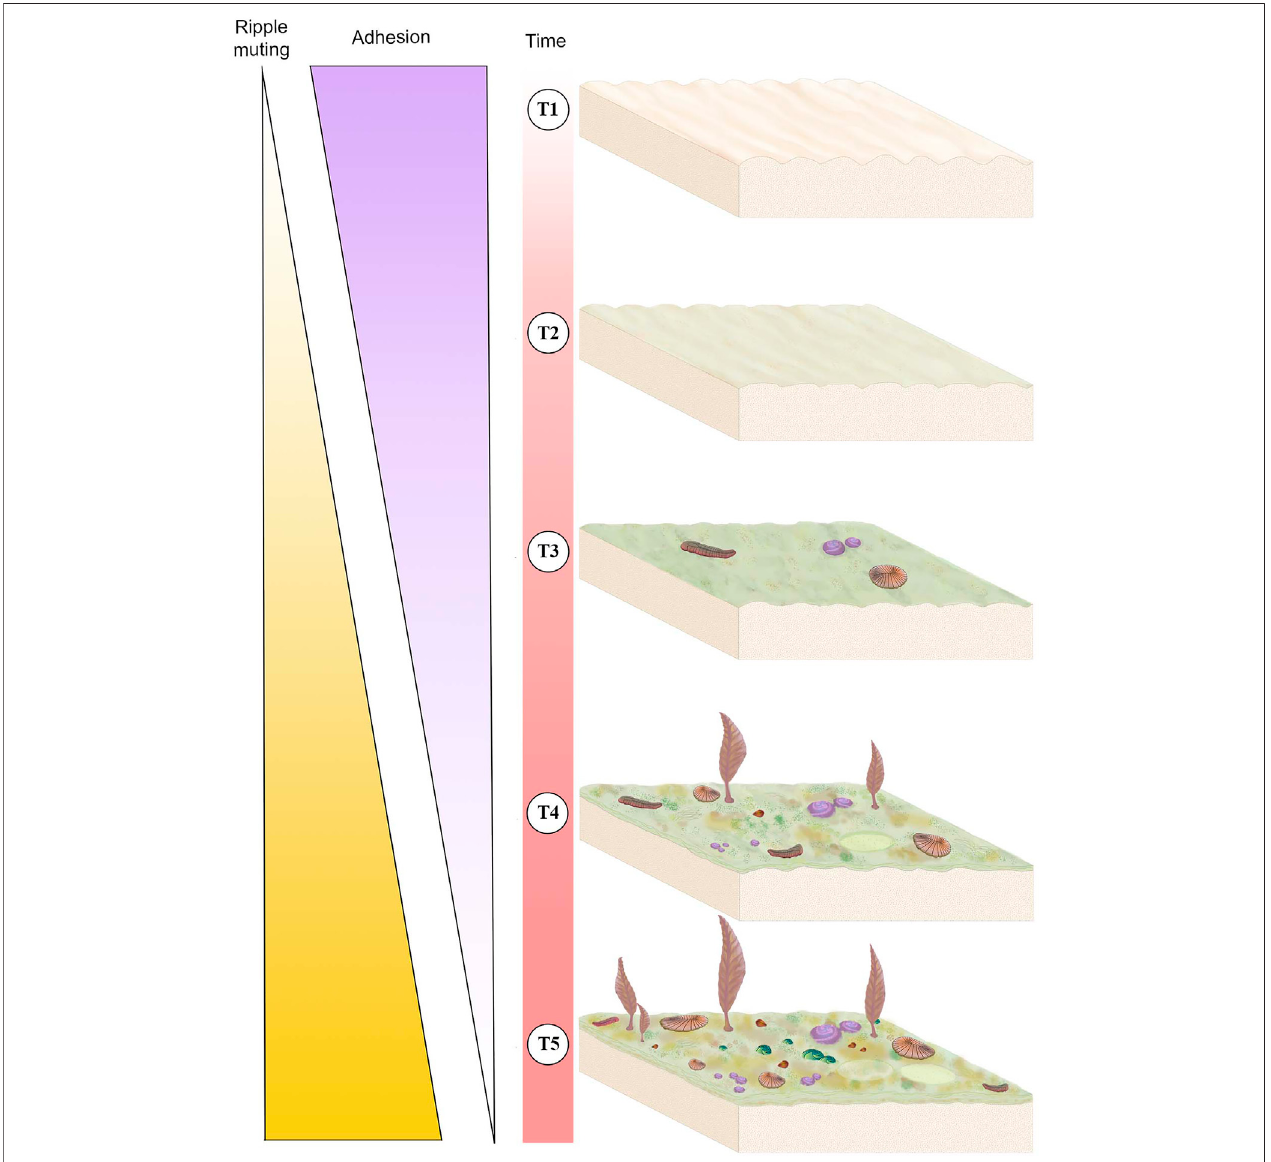
FIGURE 6 | Schematic of mat development over time (T1-T5) and its associated sedimentological and ecological impacts. Thickness of the “ Ripple muting ” and “ Adhesion ” triangles corresponds to the intensity of the variable, i.e., the thickest part of each triangle represents strong adhesion or ripple muting whereas the thinnest part represents weak adhesion or rippling muting. T1 represents a newly deposited sediment package with newly formed ripples and no mat, this surface would exhibit high adhesion and no ripple muting. T2 represents the same surface after a short period of time during which it has developed an immature mat, adhesion is moderate and ripples are only slightly muted. The same surface in T3 has a higher maturity mat and has begun to be colonized by mobile and sessile macrobiota, adhesion is moderate-to-weak and ripples are moderately muted. T4illustrates that mat continues to develop and becomemore complex in texture and thecommunity of Ediacaran macroorganisms becomes larger and more diverse, adhesion is weak and ripple muting is strong. T5 represents a mature surface that has been exposed foralongperiodoftime,illustratingathickandtexturallydiversematthatispopulatedbyahigh-densityandhigh-diversitycommunityofmacrobiota,atthisstagethereis no adhesion and ripple muting is